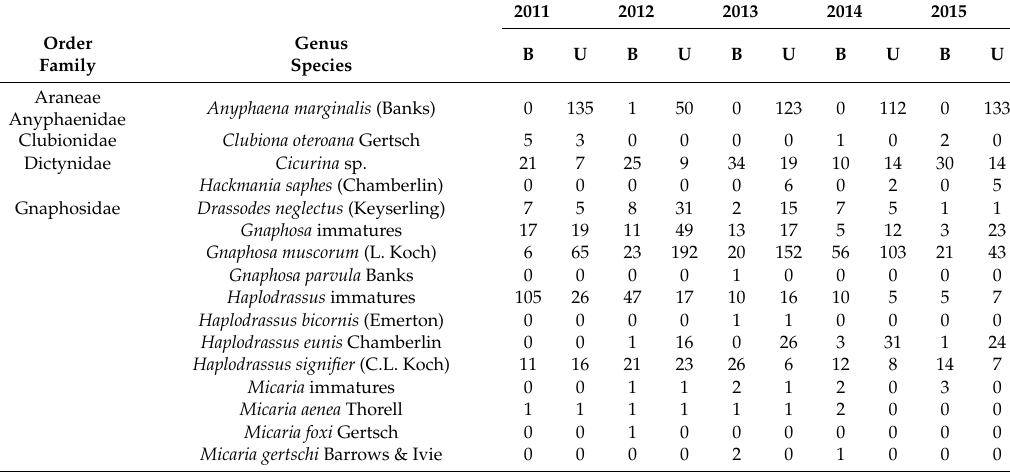
Figure S1: Species accumulation curves for samples in ( a ) ponderosa pine forest (PP), ( b ) mixed-conifer forest (MC), and ( c ) mountain valley grassland (MV) at the Valles Caldera National Preserve. Sobs is the observed number of taxa compared with the estimators Chao2 and Jackknife 2. Figure S2: NMDS scatterplots from PRIMER by treatment (B = Burned, U = Unburned) and year for ( a ) ponderosa pine forest (PP), ( b ) mixed-conifer forest (MC), and ( c ) mountain valley grassland (MV) at the Valles Caldera National Preserve, New Mexico, USA. Figure S3: R code for NMDS, autocorr, and